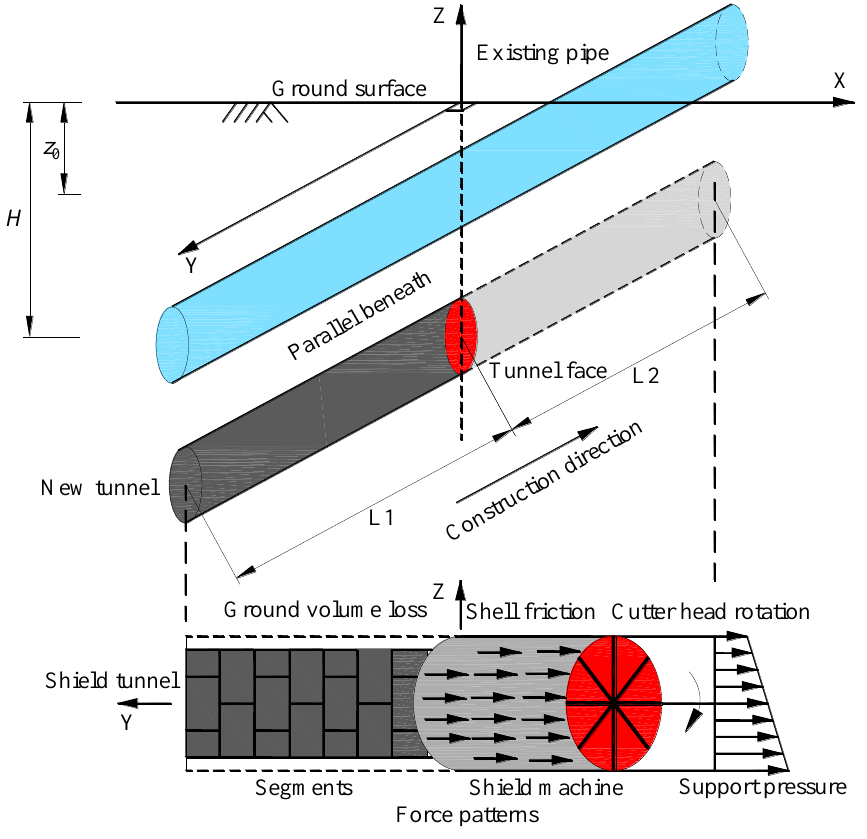
Figure 2. Interaction between shield tunnel, soil, and existing pipeline.